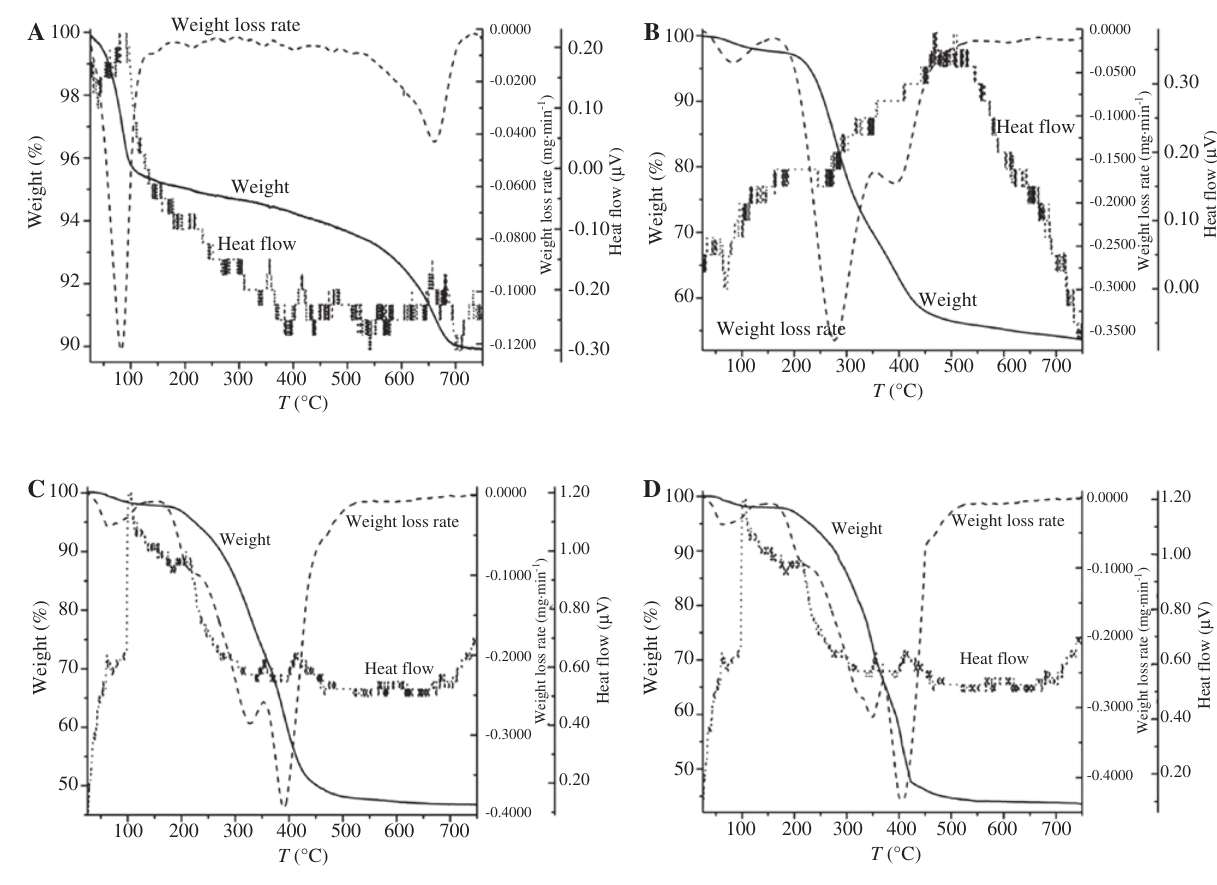
Figure 5 TGA curves of (A) MMT, (B) OMMT (STAB), (C) OMMT (DOAB), and (D) OMMT (TOAB).